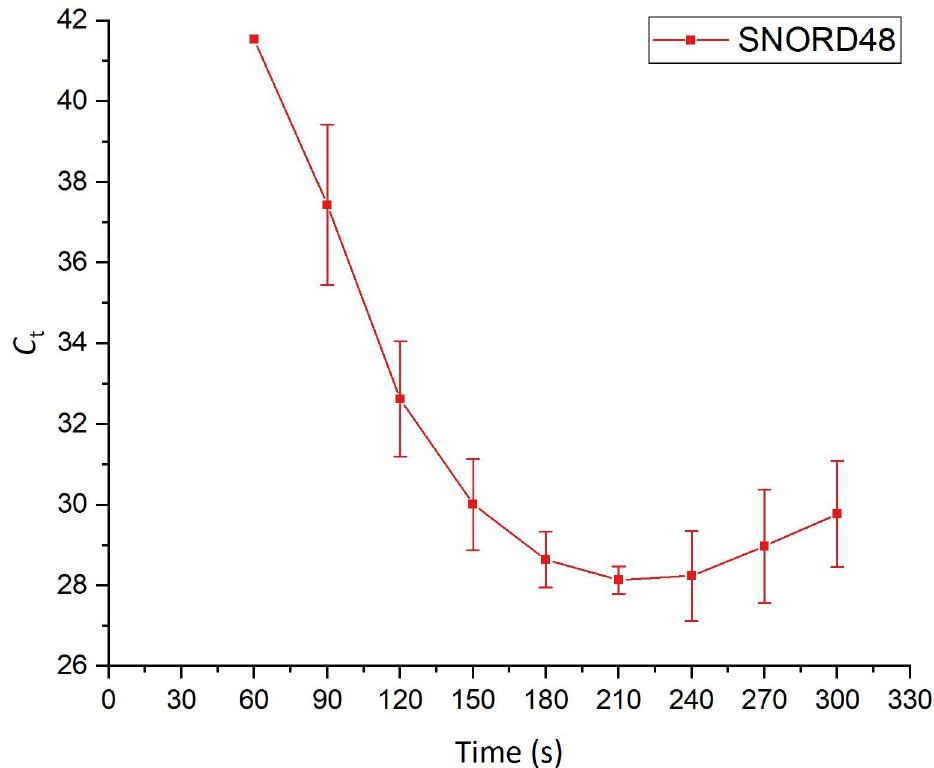
Fig 11. Time series showing the elution profile of the endogenous control RNA SNORD48 (57 b) from 5000 MCF7 cells (n = 3).